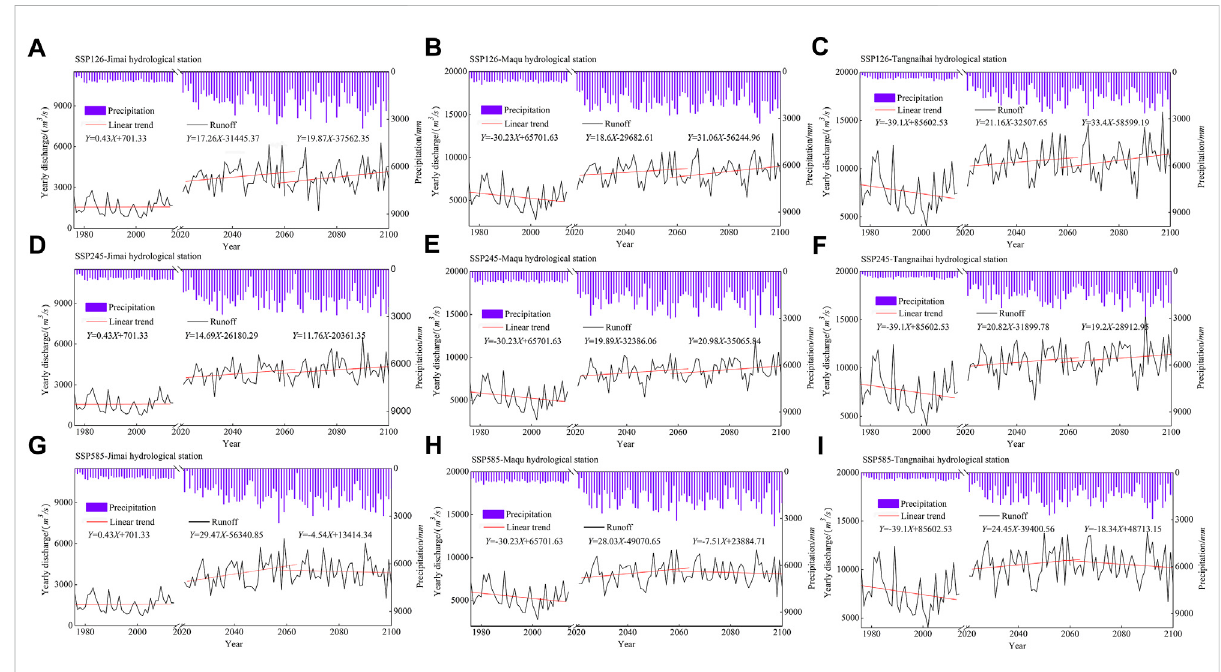
FIGURE 5 Temporalvariationsandtrendsoffutureyearlydischargeatthethreehydrologicalstations(Jimai (A,D,G) ,Maqu (B,E,H) andTangnaihai (C,F,I) )in the SAYR under three scenarios (SSP126 (A – C) , SSP245 (D – F) and SSP585 (G – I)